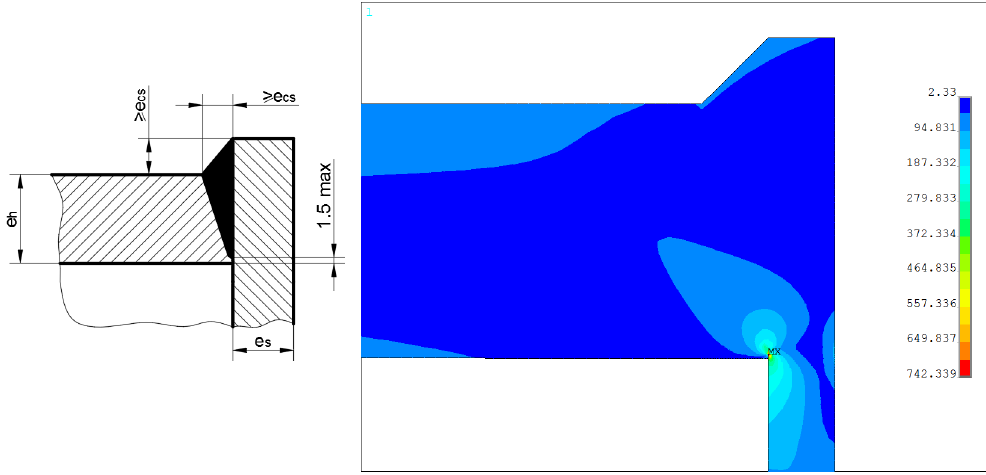
Figure 20. Equivalent stress distribution in the endplate “d”—endplate—tube junction.